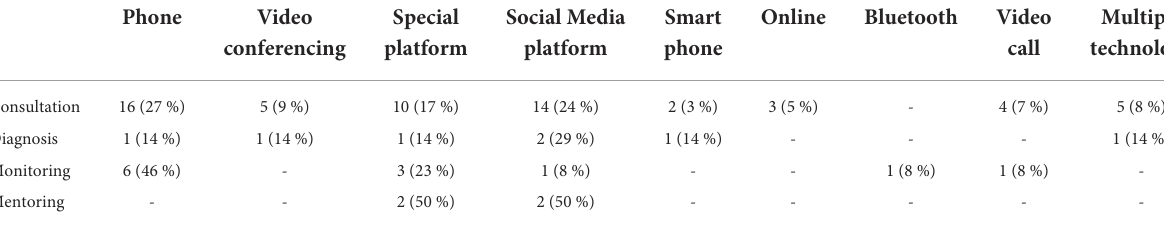
TABLE 3 Applied technology in telemedicine systems based on functionality.